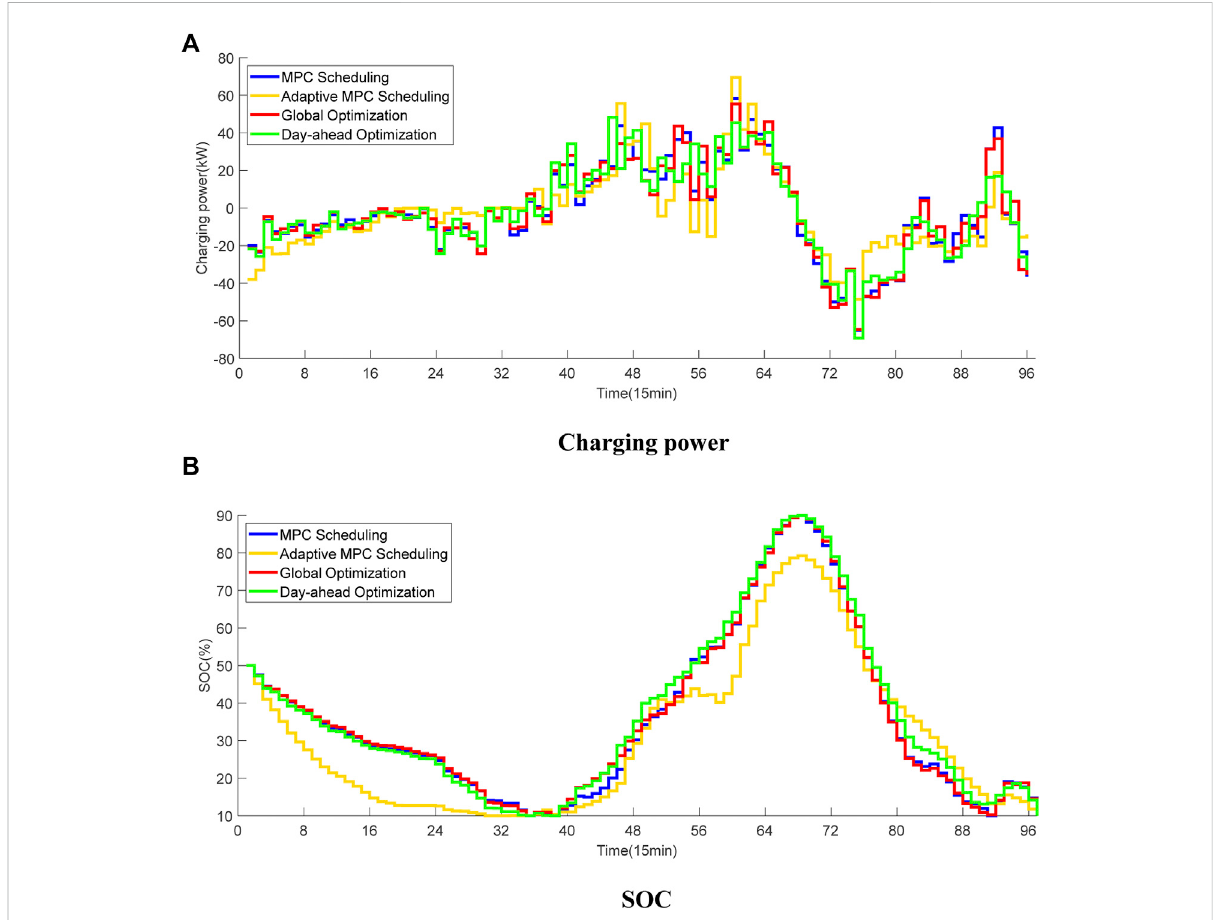
FIGURE 10 Charging power and SOC curves of the ESS under different scheduling strategies. (A) Charging power. (B) SOC.